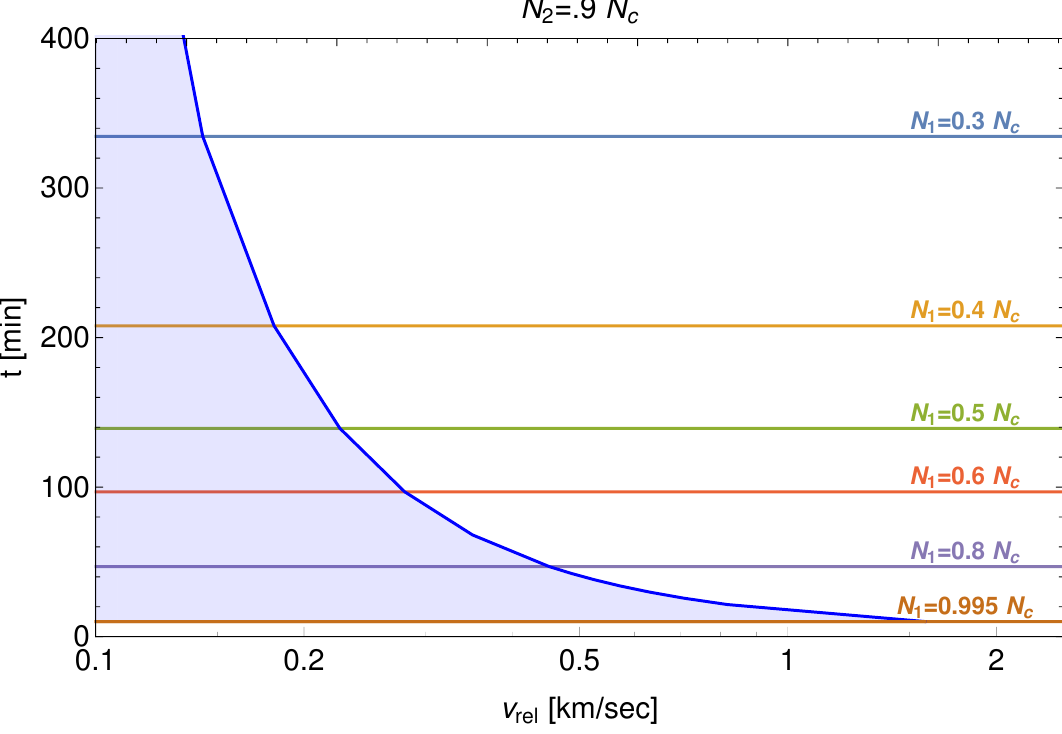
, given that (cid:3)